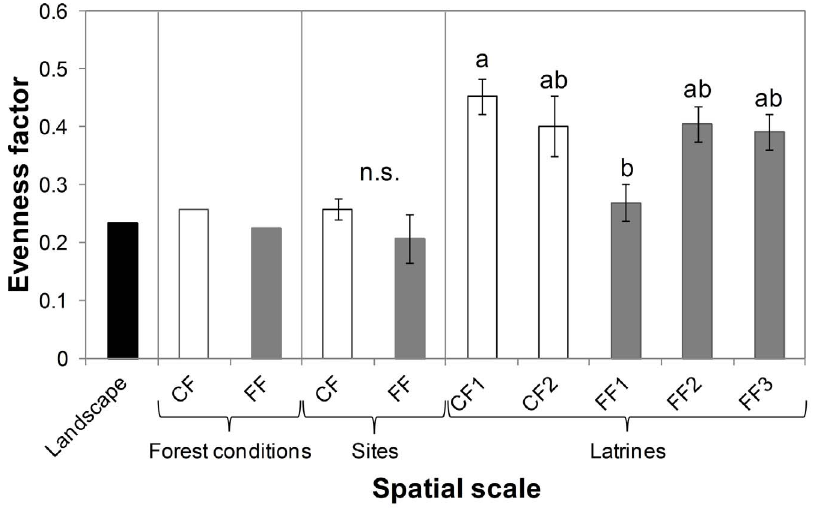
Figure 4. Species evenness in seeds deposited by spider monkeys in latrines located in continuous and fragmented forests in the Lacandona region, Mexico. Differences across spatial scales are indicated; from the landscape scale (i.e., including both forest conditions) to the latrine scale. Means ( 6 SE) per site and per latrine are indicated for the site and latrine spatial scales. Significant differences among sites are indicated with different letters ( P =0.01). The evenness factor did not differ between forest conditions (n.s., P . 0.05).